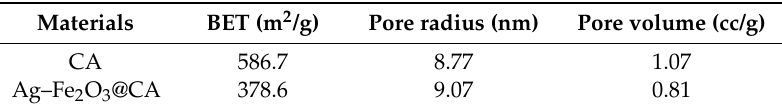
Table 1. Textural property of CA and Ag–Fe 2 O 3 @CA.